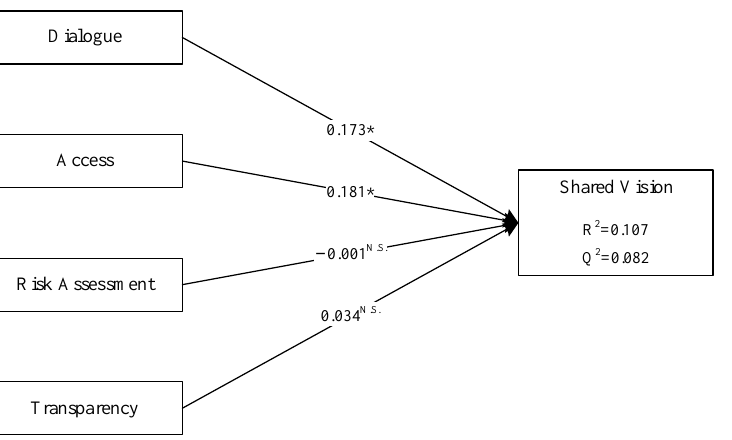
Figure 1. Results of structural model. Note: * is significant at p < 0.05; ** p < 0.01; *** p < 0.001; N.S. = non-significant.